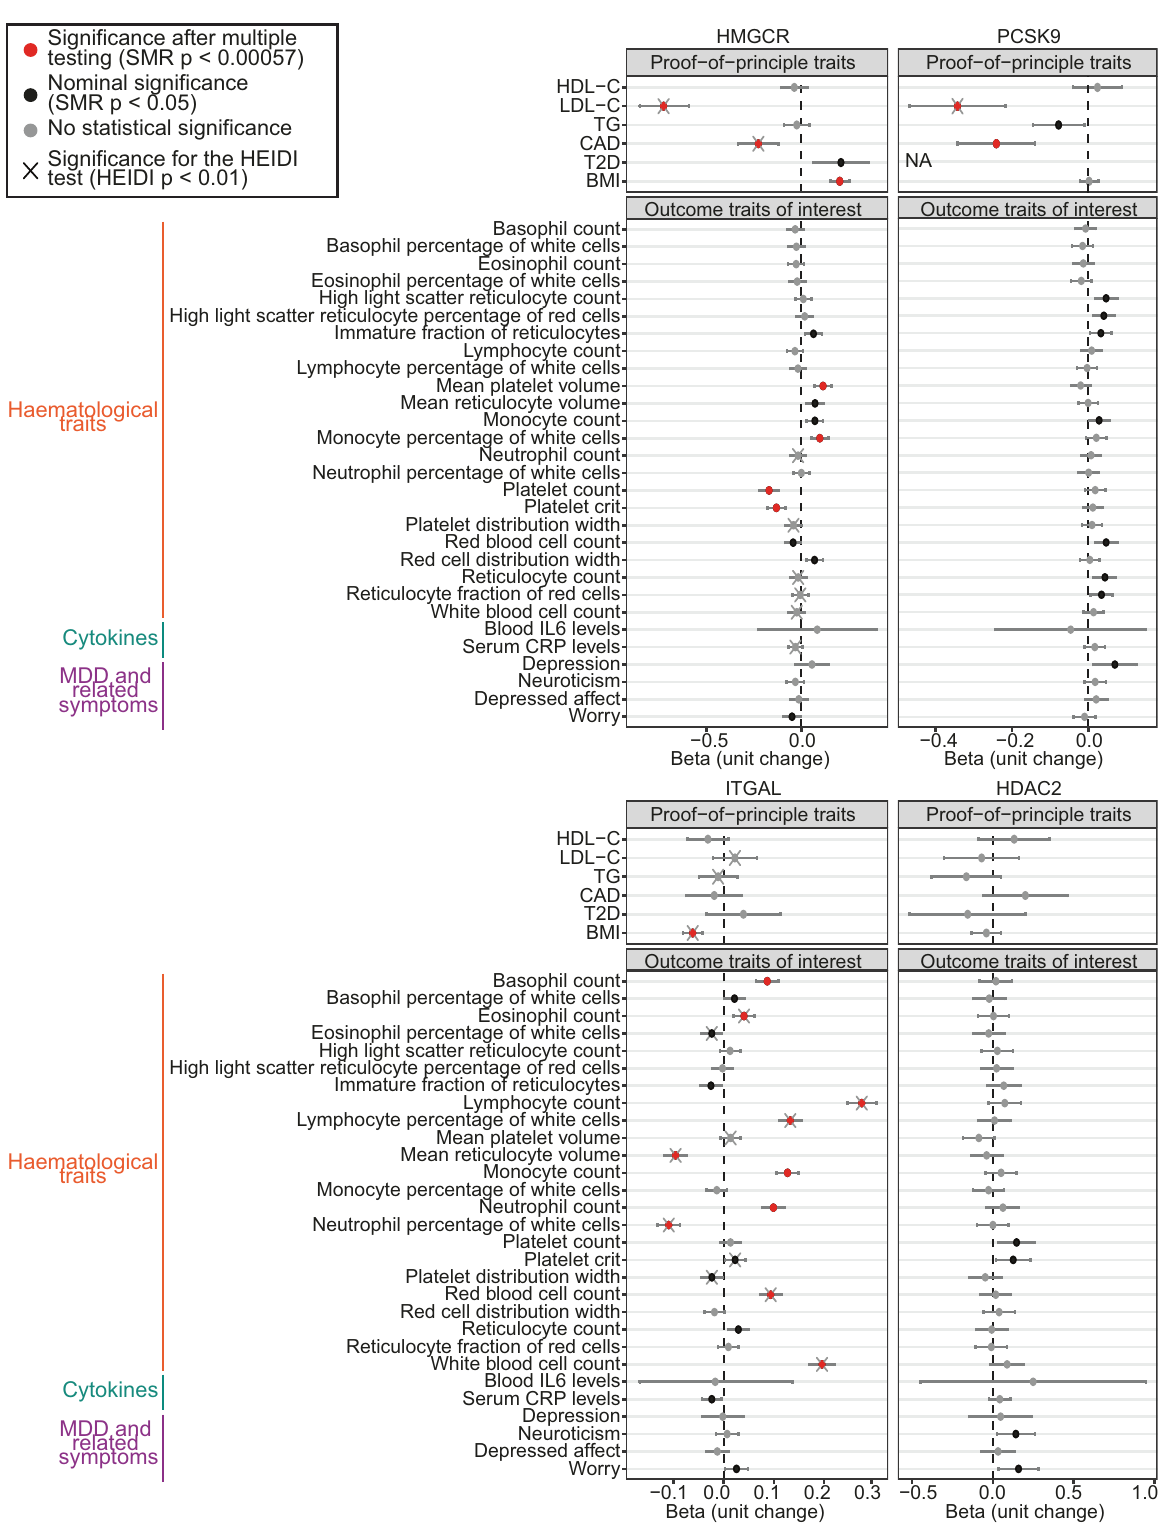
Fig. 3 MR analyses of HMGCR , ITGAL, HDAC2 and PCSK9 gene expression in blood with various haematological, cytokine and depression- related traits. Dot plots show the associations (beta) between gene expression and traits, and error bars show the 95% con fi dence intervals. The effect sizes are harmonized to represent the changes in trait per one standard deviation decrease in gene expression (thus re fl ecting genetically proxied target inhibition). The units of beta values are not standardized. Red dots represent associations with statistical signi fi cance after multiple testing correction (SMR p < 0.00057), and black dots represent associations with nominal signi fi cance (SMR p < 0.05). Associations with signi fi cant HEIDI p -values (HEIDI p < 0.01) are marked by ×. For PCSK9 , the genetic instrument was not pro fi led in the type II diabetes (T2D) dataset and the result was thus labelled with “ NA ” ( “ not available ”